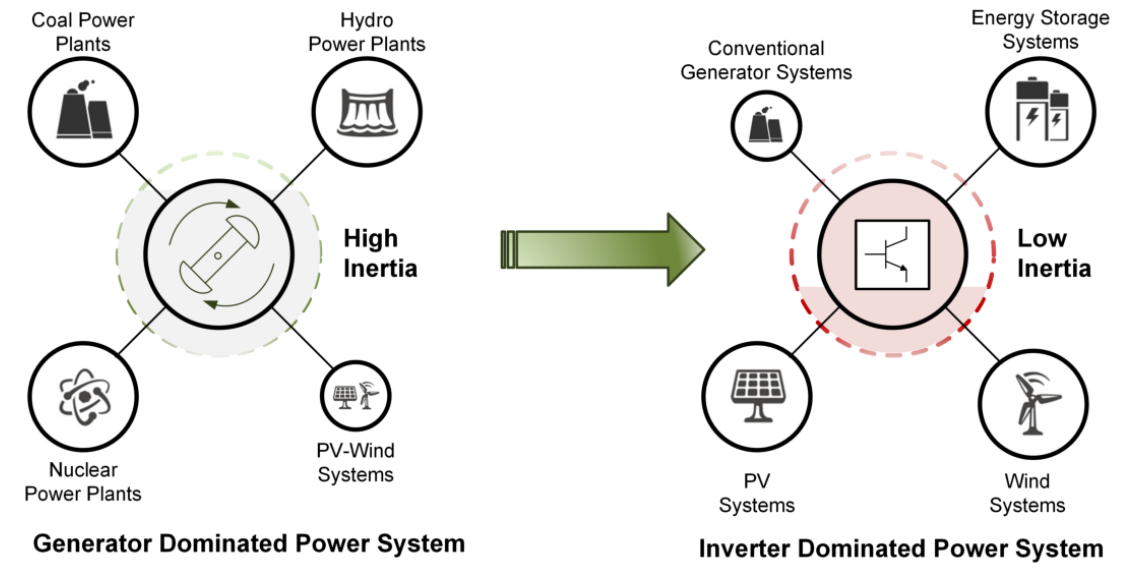
Figure 1. Evolution towards variable inverter-based renewable energy sources (VIBRES) dominated power systems. The size of the circle of each generation component is related to the size of its contribution to each system illustrated on the left and right